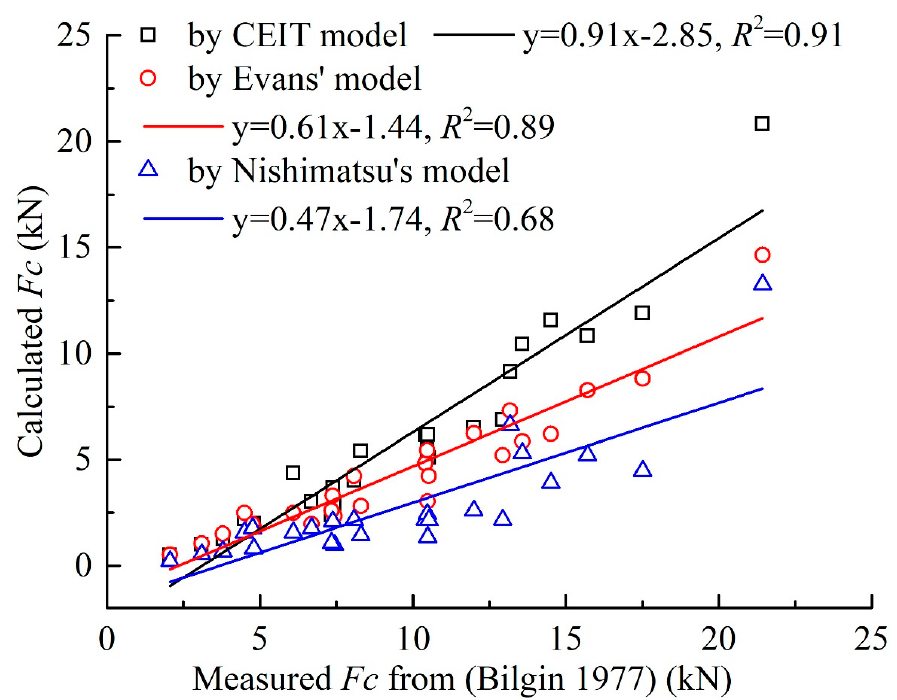
Figure 12. Comparison of the performance of different models in estimating the peak cutting forces in cutting limestone.